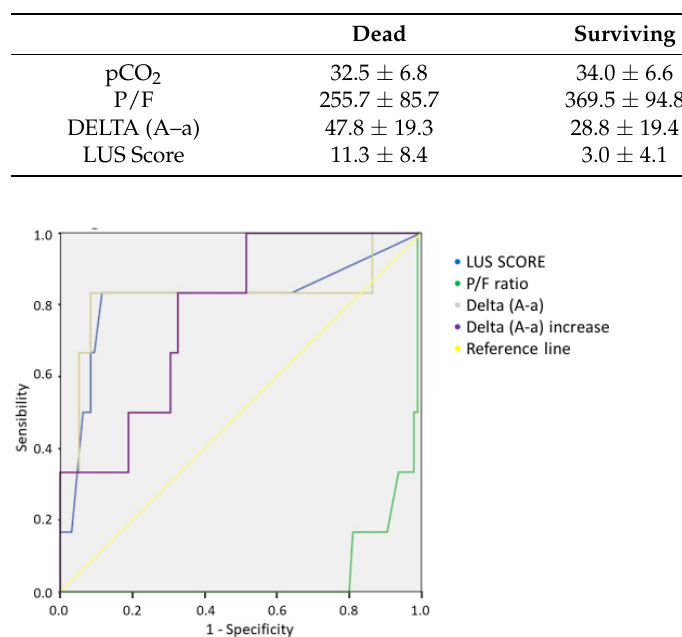
Figure 6. Comparison of ROC curves of LUS score, P/F ratio, delta (A–a), and delta (A–a) increase for the 30-day mortality of COVID-19 patients.